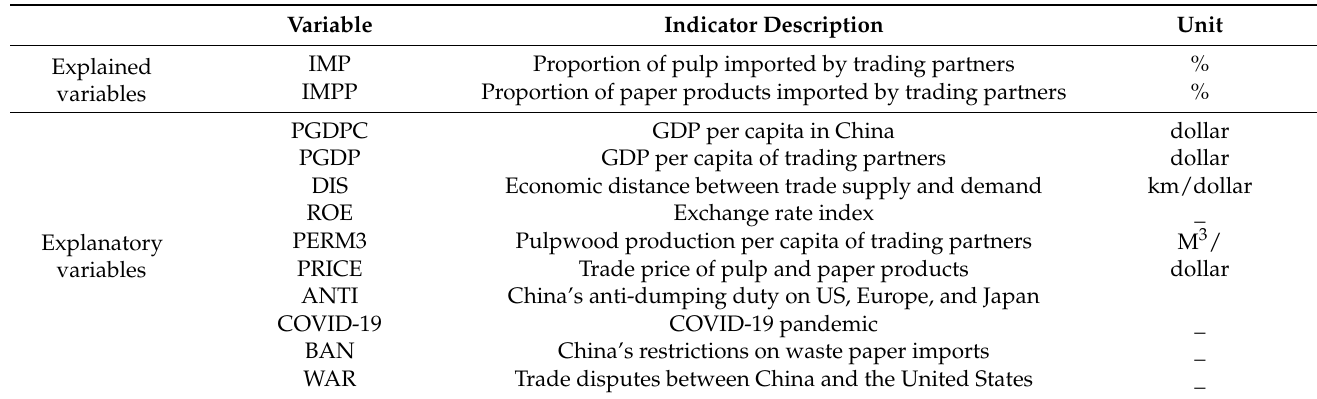
Table 2. Variable